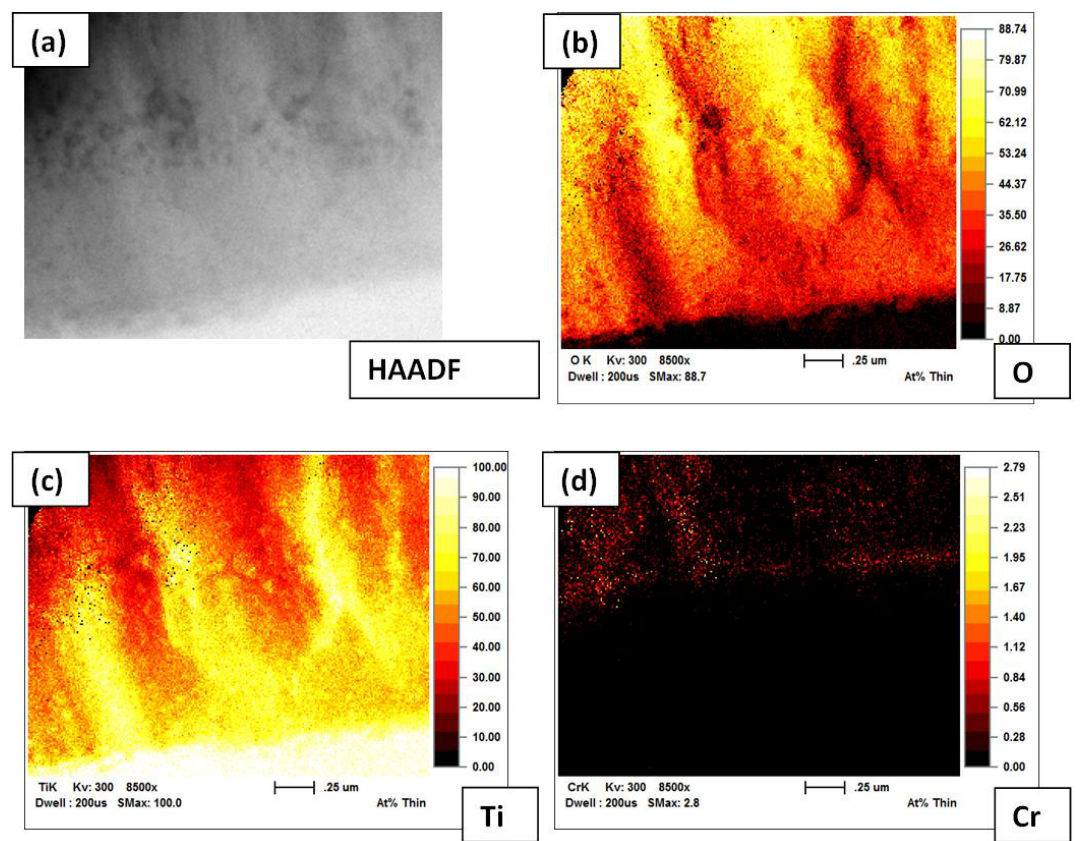
Figure 8. Analysis of the Cr doped TiO NTs by FE-TEM ( a ) high-angle annular dark-field 2 (HAADF)-image and EDX-Mapping results of ( b ) titanium ( c ) oxygen and ( d ) chromium in the Cr doped TiO NTs. Chromium is detected only in TiO NTs, while no chromium is 2 2 detected in the thin bulk TiO layer present at the bottom TiO NTs (Figure 2 2